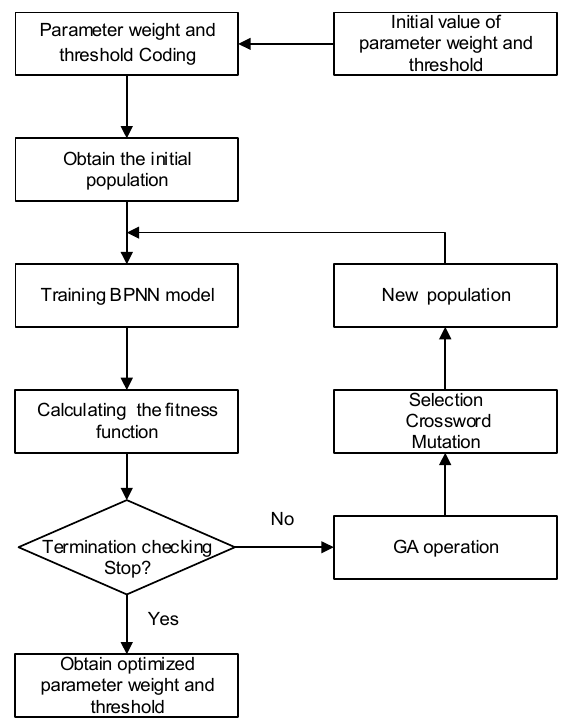
Figure 6. Flow chart of optimizing the BP neural network parameters with a GA.